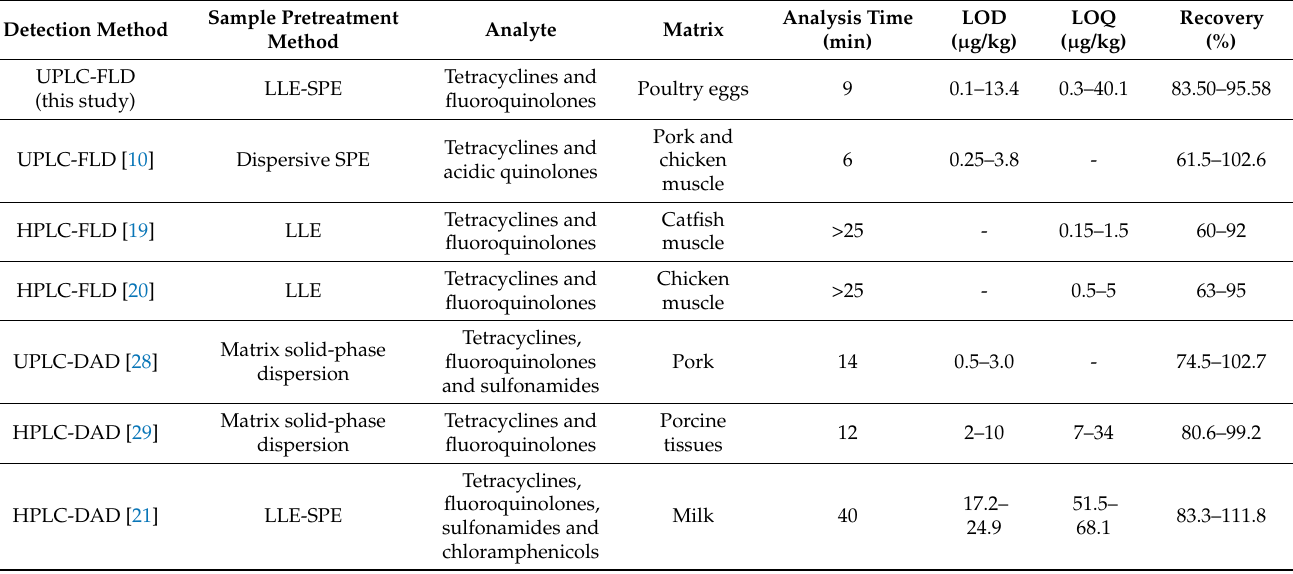
Table 9. Comparison with previously reported LC